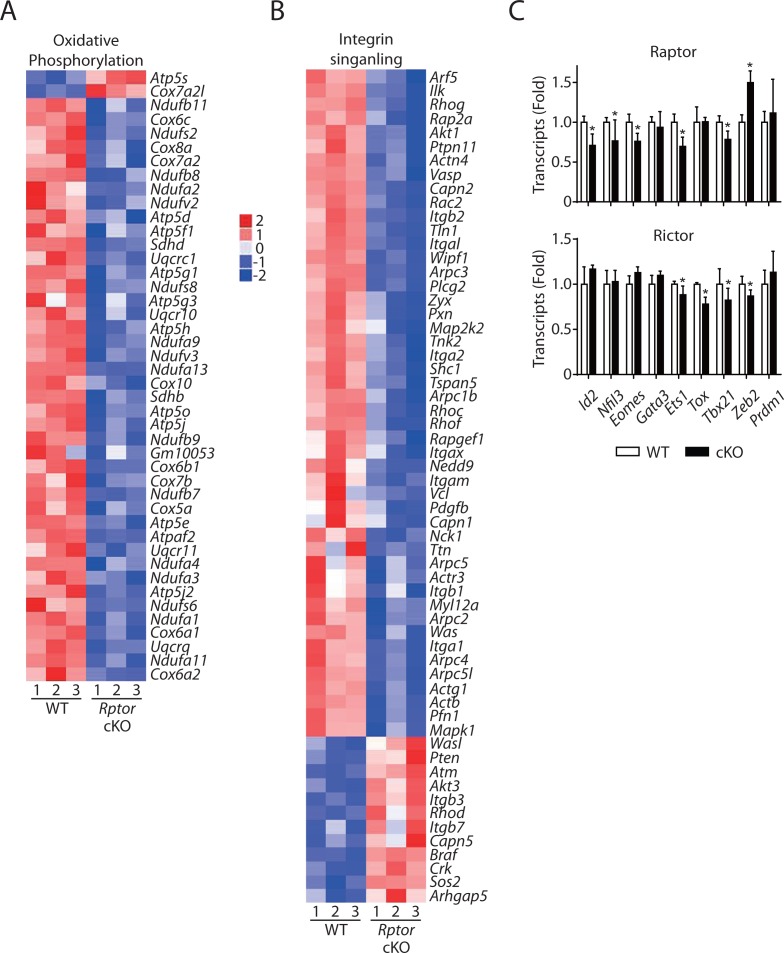
Altered oxidative phosphorylation and integrin signaling in Raptor-deficient NK cells indicated by RNA sequencing.(A, B) IPA analyses revealed enrichment of oxidative phosphorylation (A) and integrin signaling (B) in Rptor cKO NK cells as demonstrated via the heatmap. (C) mRNA level of key transcription factors governing NK cell development in Raptor- (top) or Rictor- (bottom) deficient NK cells normalized to corresponding WT control.